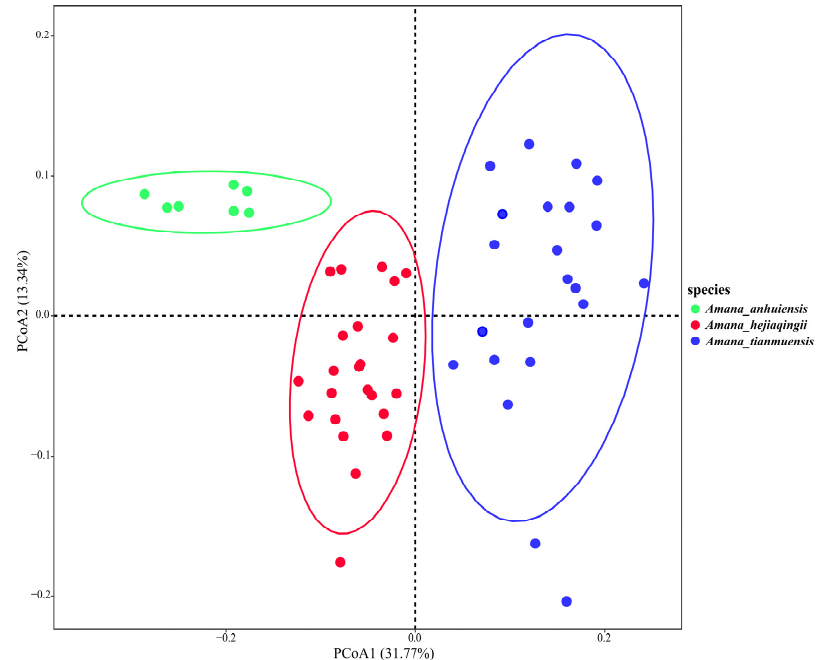
Figure 5. Principal coordinates analysis plot of Amana anhuiensis , Amana hejiaqingii and Amana tianmuensis . The ellipse represents the 95% confidence interval.